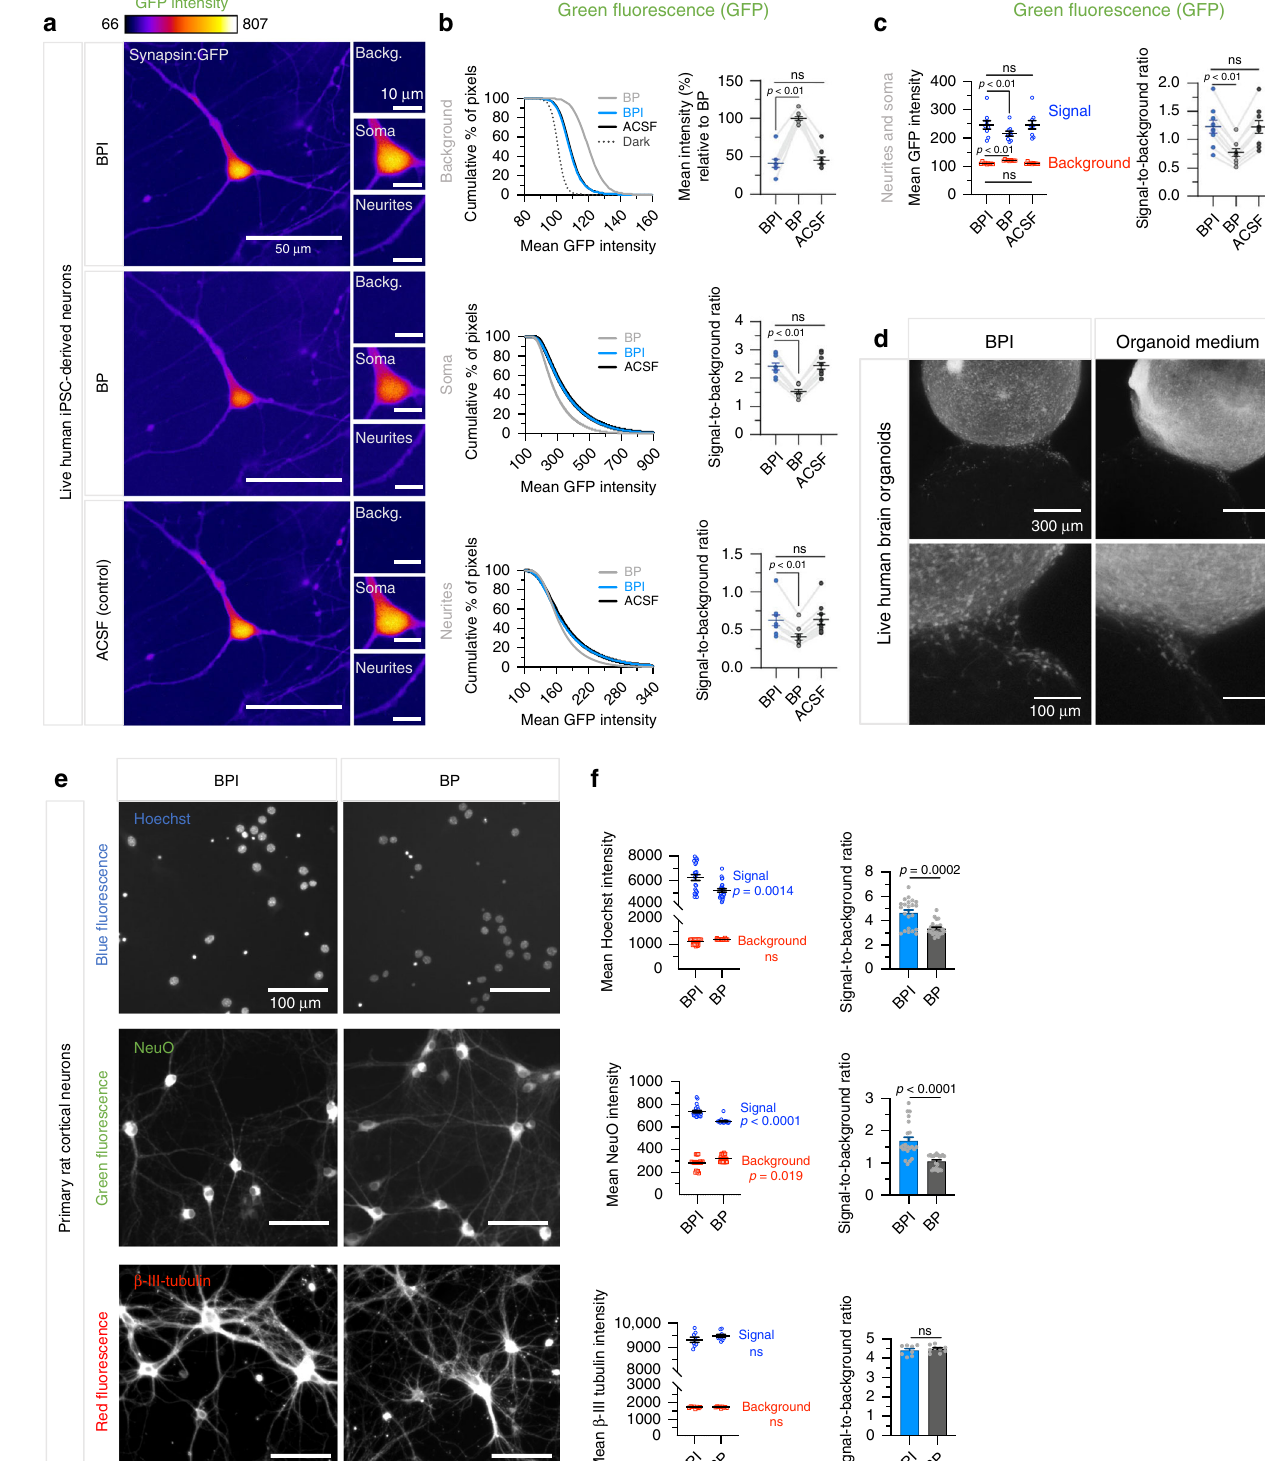
468/557 nm). For Hoechst ™ 33342 (excitation/emission at 361/ 497 nm), the neurons were either labeled live or fi xed fi rst. For each fl uorophore, all images were conducted with identical ima- ging parameters but in different media (Fig. 2e, f and Supple- mentary Fig. 1c – f). For longer wavelengths (red), we found no signi fi cant improvement in signal-to-background ratio with images taken in BPI (Fig. 2e, f and Supplementary Fig. 1e,